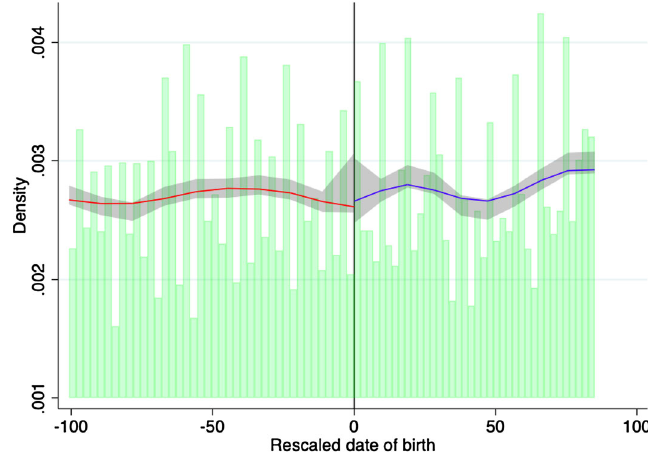
Fig. 2 Density test at the eligibility threshold, 2007 cohort 2007 cut-off cannot be rejected, with a t value of − 0.90 and a p value of 0.37. This was expected due to the timing of the announcement of the